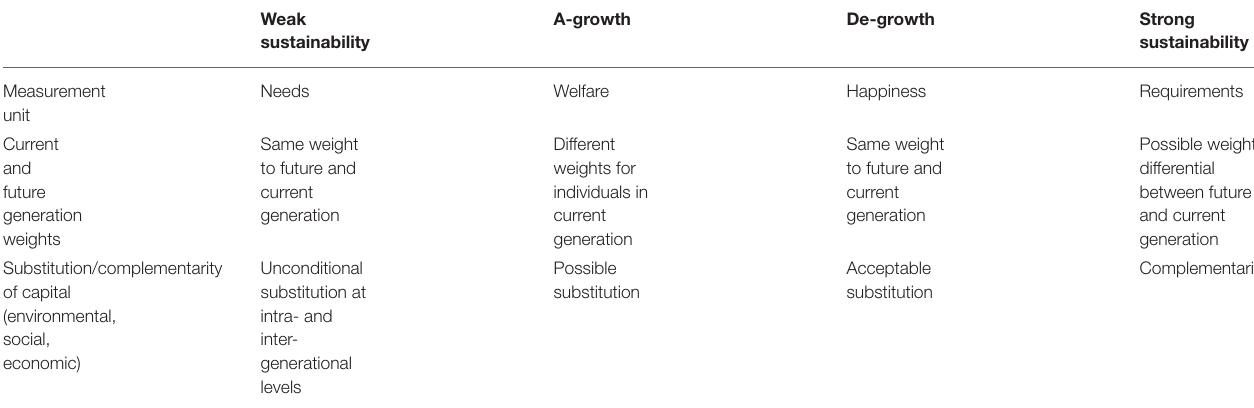
TABLE 1 | Assumptions employed in the different sustainability